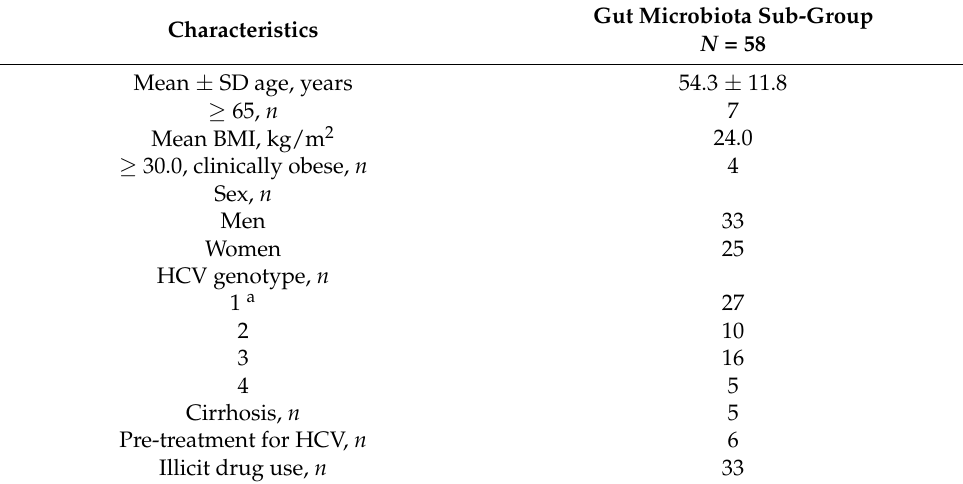
Table 1. Baseline